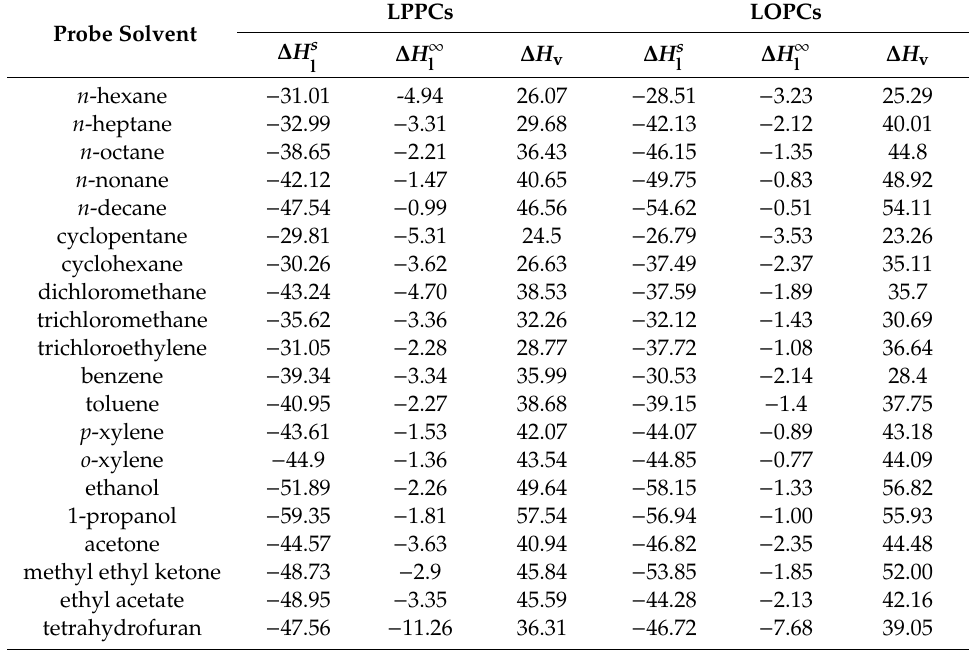
Table A3. Thermodynamic parameters of probe solvents (kJ /